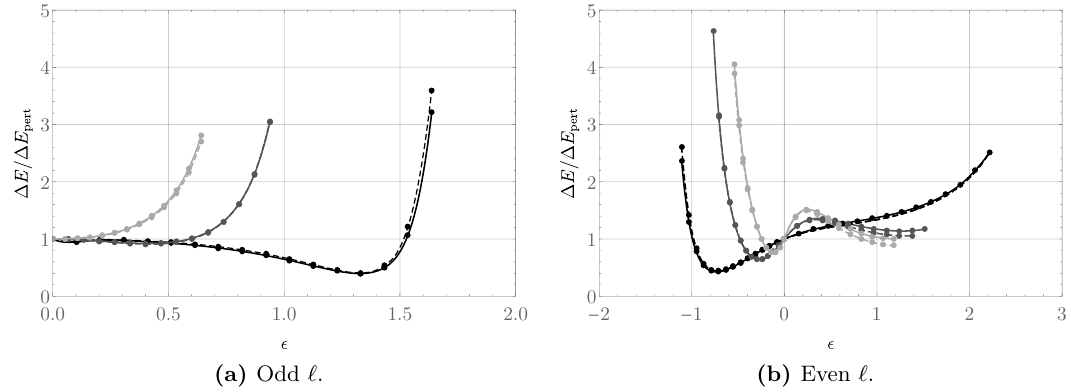
Figure 5. The zero-temperature differenced energy ∆ E normalized by its perturbative behav- ior ∆ E pert on the deformed spheres given by (4.8) and (4.9). Solid lines show results for the massless Dirac fermion, while dashed lines are for the massless minimally coupled scalar (points are numerical data; the curves are drawn to guide the eye). From black to light gray, the curves corresponds to ‘ = 1 , 3 , 5 (left) and ‘ = 2 , 4 , 6 (right). It is striking that the Dirac fermion and scalar give very similar